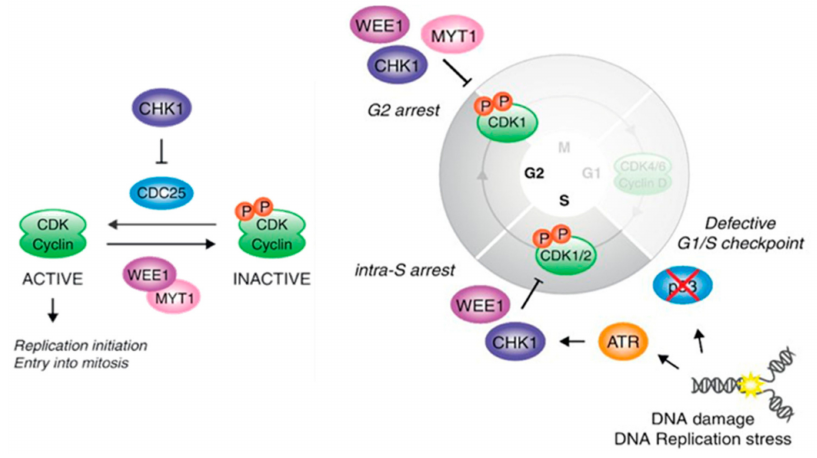
Figure 1. Cell cycle control: DNA damage checkpoint (modified from Aarts et al. [55]). Reproduced with permission from Nick Turner, Current Opinion in Pharmacology; published by Elsevier,